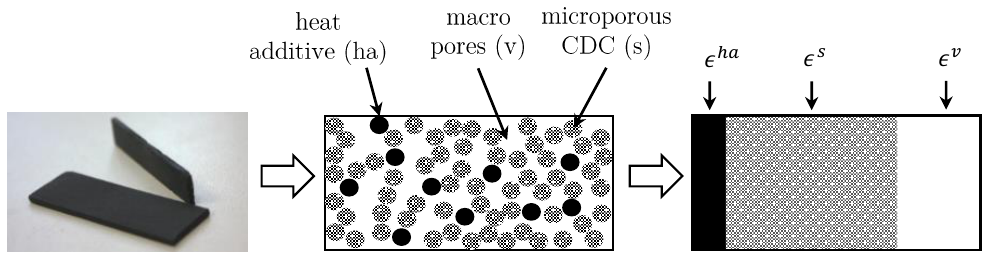
Figure 2. Image of manufactured plate compound (left side), sketch of the material composition consisting of solid heat additive, micro-porous adsorbent (CDC = carbide derived carbon) and transport (macro-) pores and simplified material model (right